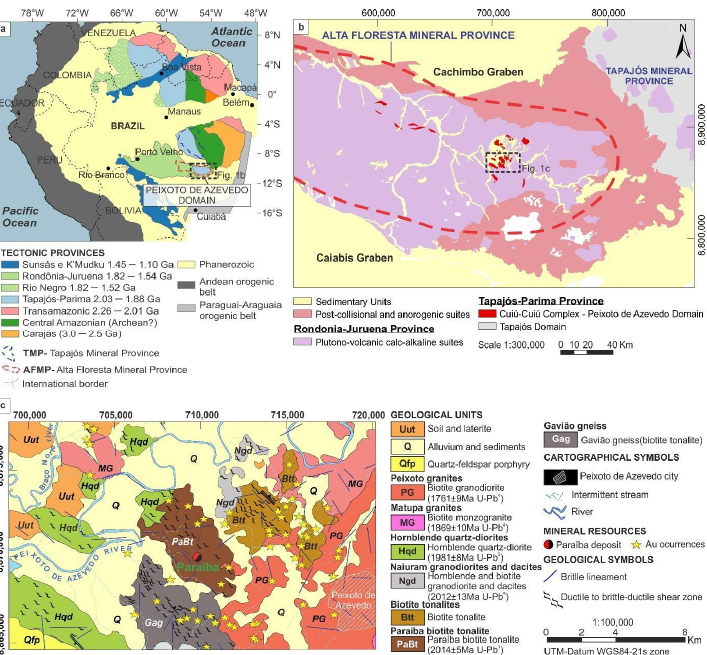
Figure 1. Regional and local geology. ( a ) Geochronological provinces of the Amazonian craton, with the Tapajós and Alta Floresta Mineral Provinces highlighted in red (modified from [32]); ( b ) eastern sector of the Alta Floresta Mineral Province (AFMP) (modified from [33 – 34]); ( c ) local geology of the Paraíba deposit with the main lithotypes (modified from [35]). Geochronological ages from: 1 — [12], 2 — [1], 3 — [15], 4 — [36], and 5 — [35].